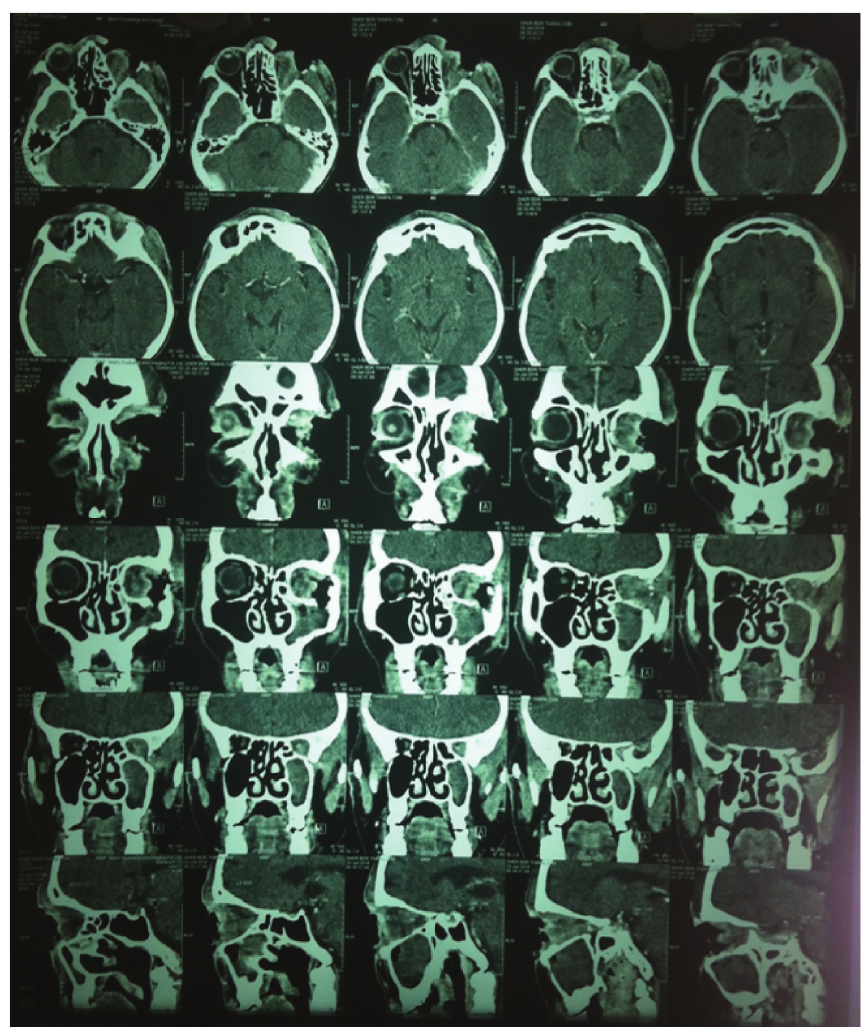
Figure 2: Axial and Coronal section CT scan showing soft tissue density area in left maxillary sinus and left orbit with erosion of the floor and lateral wall of the orbit. No intracranial abnormality seen.